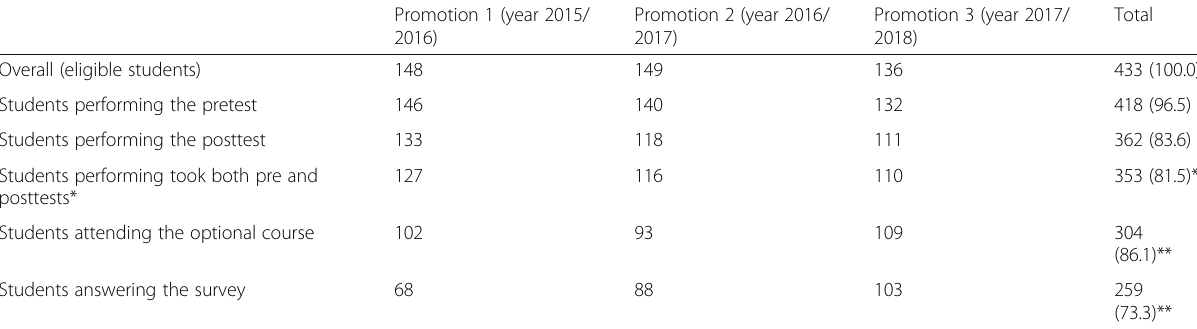
Table 1 Overall selected medical